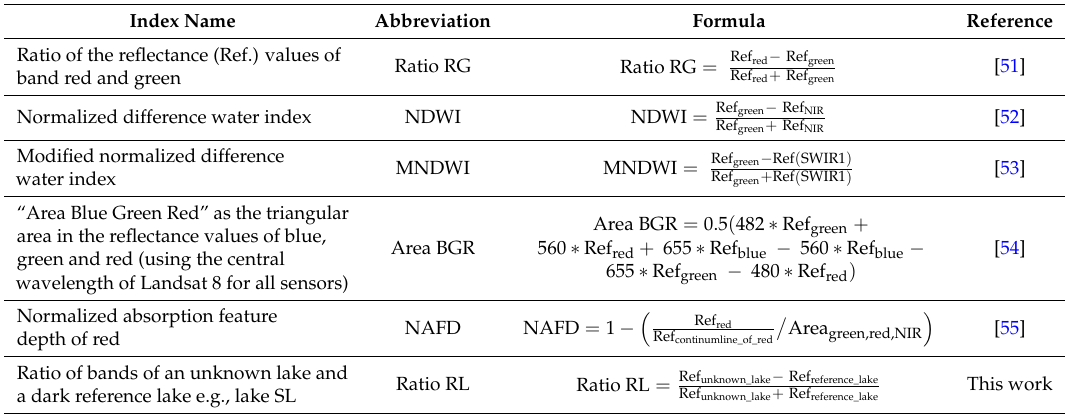
Table 5. Overview of the spectral indices.